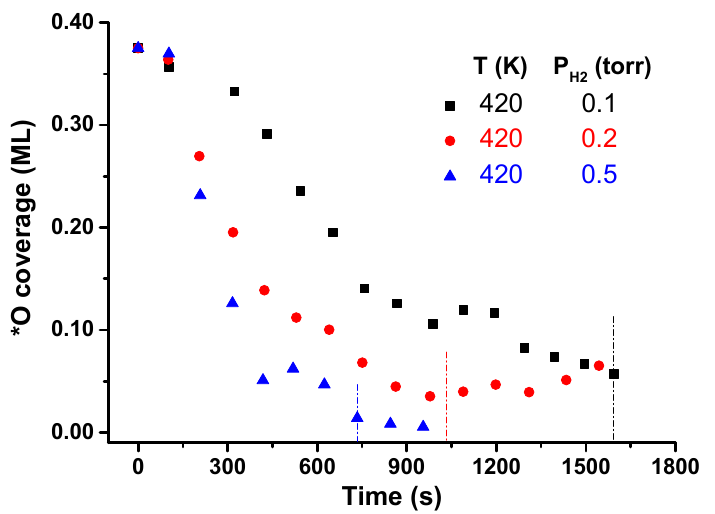
Figure 7. WFR reaction evolution at 420 K and variable pressure conditions (0.1–0.5 Torr H 2 ). Vertical lines indicate the endpoint of the reaction at each working pressure.